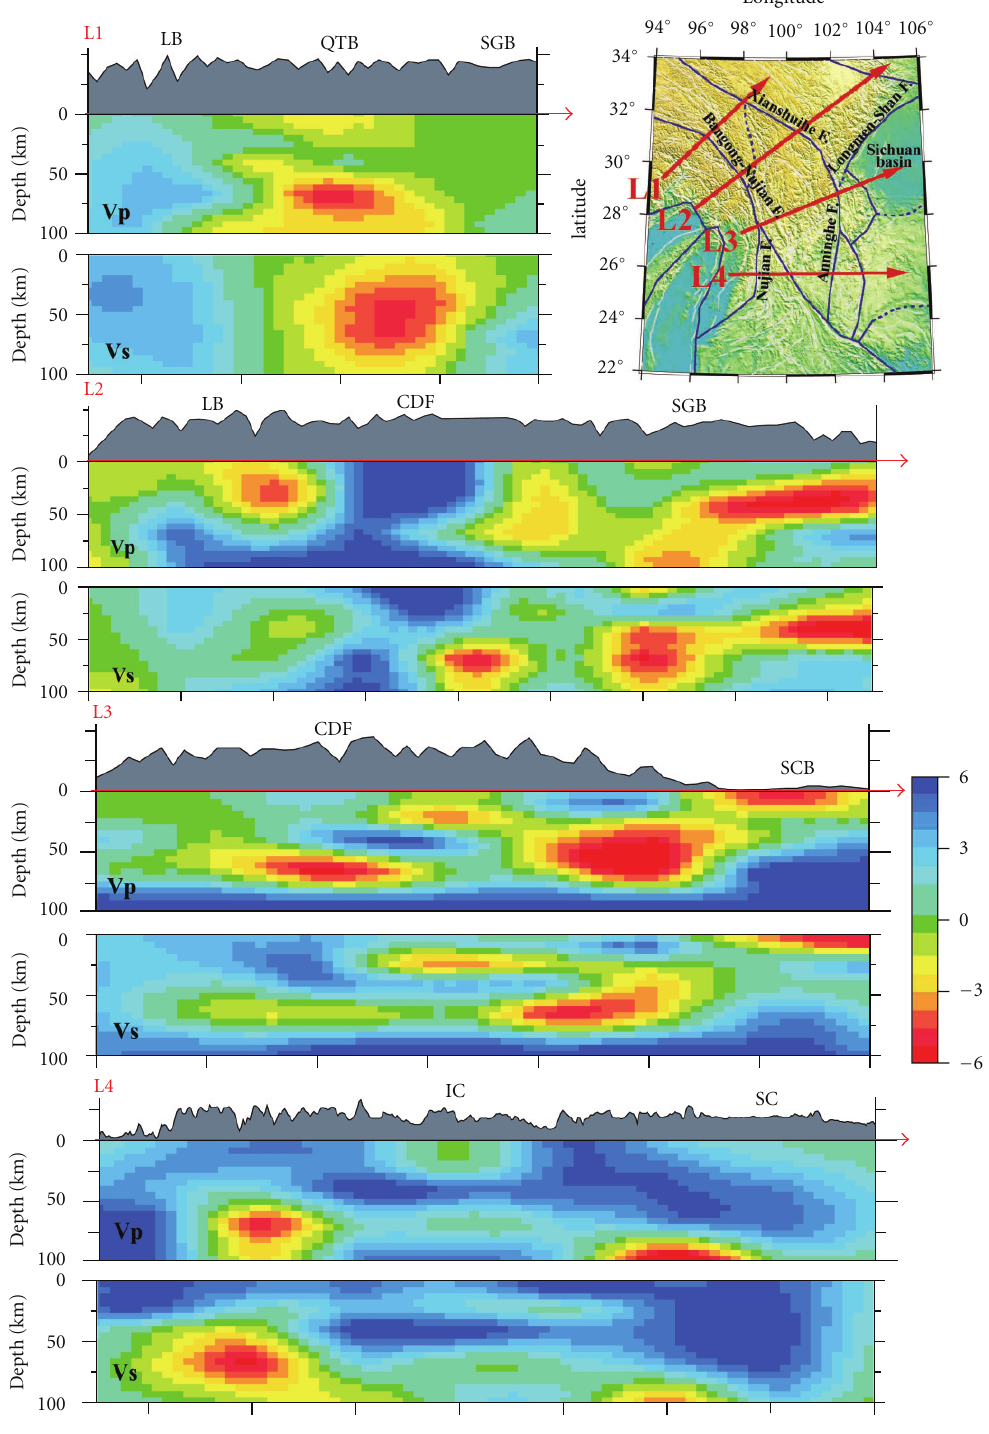
Figure 6: Vertical cross-sections of P- and S-wave velocity images along the lines shown on the upright inset map. Red color indicates low velocity while blue color denotes high velocity. The surface topography is shown on the top of each section. LB: Lhasa Block. QTB: Qiangtang Block. SGB: Songpan-Ganzi block (fold system). CDF: Chuan-Dian Fragment. SCB: Sichuan Basin. IC: Indochina. SC: South China block, LB: Lhasa